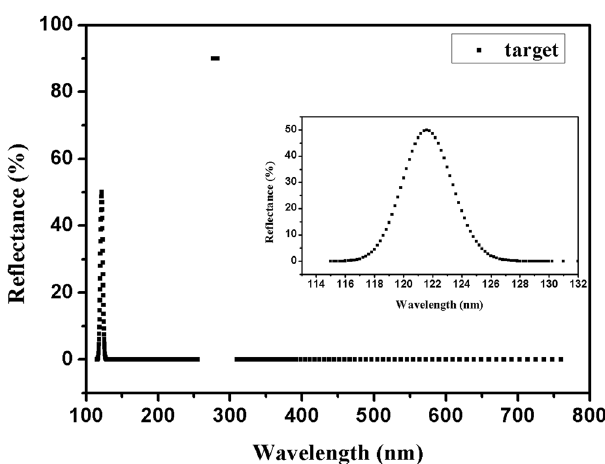
Figure 6. Selected targeted spectral performance in final optimization (Fig. 5) in Optilayer software. The inset is the magnified 121.6 nm stopband with a bandwidth of 4 nm, which is described by a Gaussian